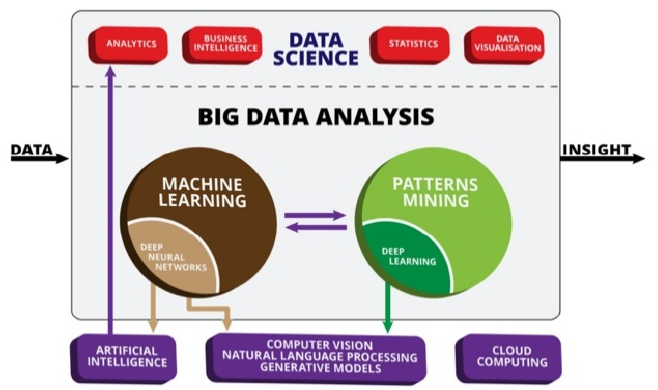
Figure 2. Analysis model of large data sets for machine learning.